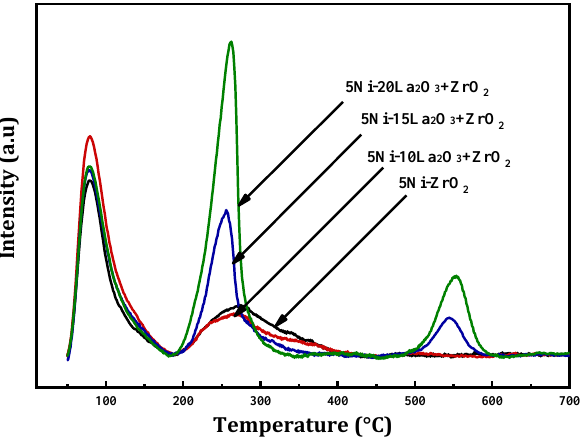
Figure 3. Temperature-programmed desorption (TPD)-CO 2 profiles of 5Ni-ZrO 2 and lanthanum-promoted 5Ni-ZrO 2 catalysts.